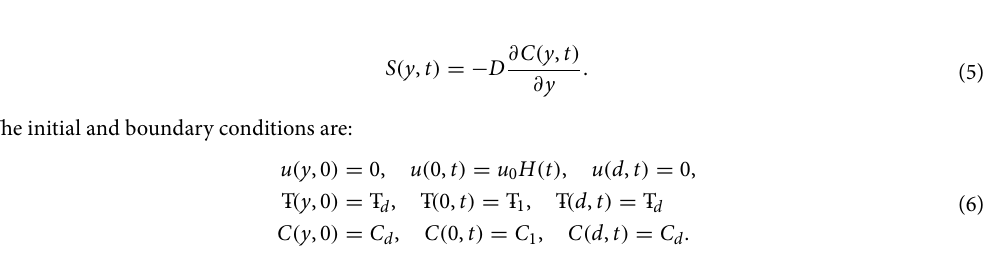
Figure 1. Geometry of the